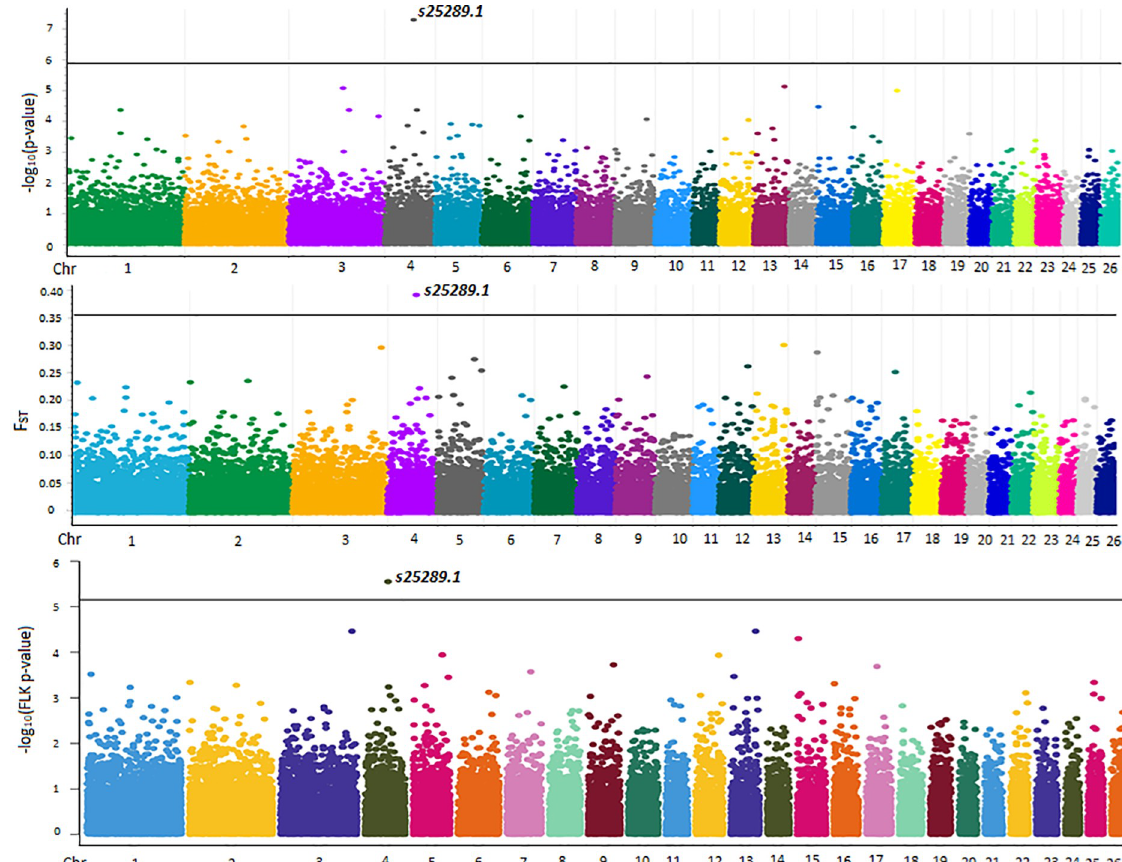
Fig 4. Manhattan plots of–log 10 (p-values) of SNPs (top), raw F ST estimates (middle) and FLK statistic (bottom) across autosomes. Grey line on the upper Manhattan plot denote threshold (-log 10 (p-value) = 5.893) for genome wide significance, in the middle the 99.999 th percentile bound (0.3554) and the threshold for the FLK statistic (bottom). The id of significant SNP is also presented. FLK plot was constructed with the CMplot package (https://github.com/YinLiLin/R-CMplot) in R (http://www.r-project.org/).